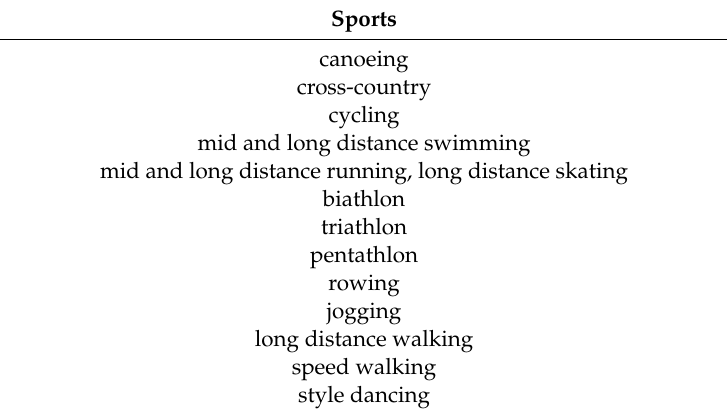
Table 1. Endurance